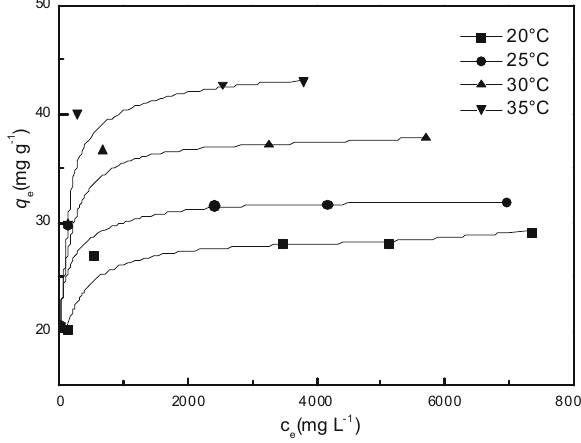
Figure 6: Plots of c e against q e for the GPC adsorption on resin 001 × 7 at di ff